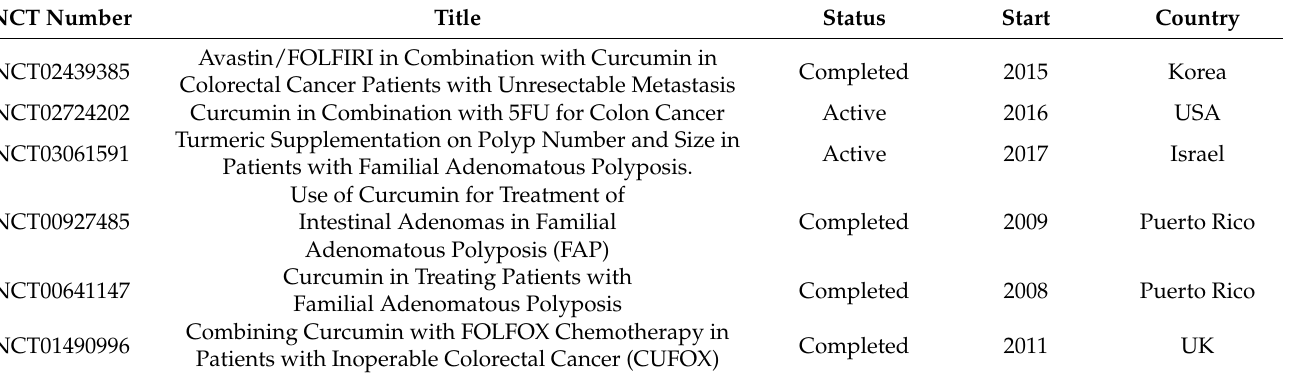
Table 2. Clinical trials evaluating curcumin as an adjuvant for chemotherapy in colorectal and pancreatic